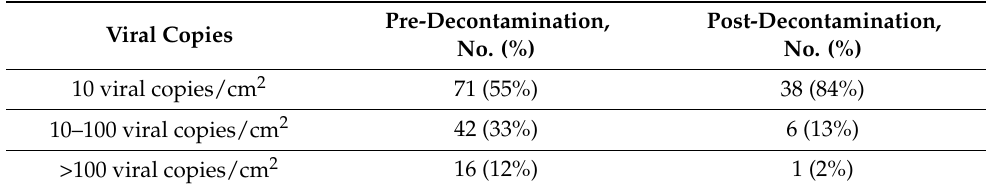
Table 2. Quantitative Distribution of SARS-CoV-2–Positive Fomites Pre- and Post-Chemical De- contamination.